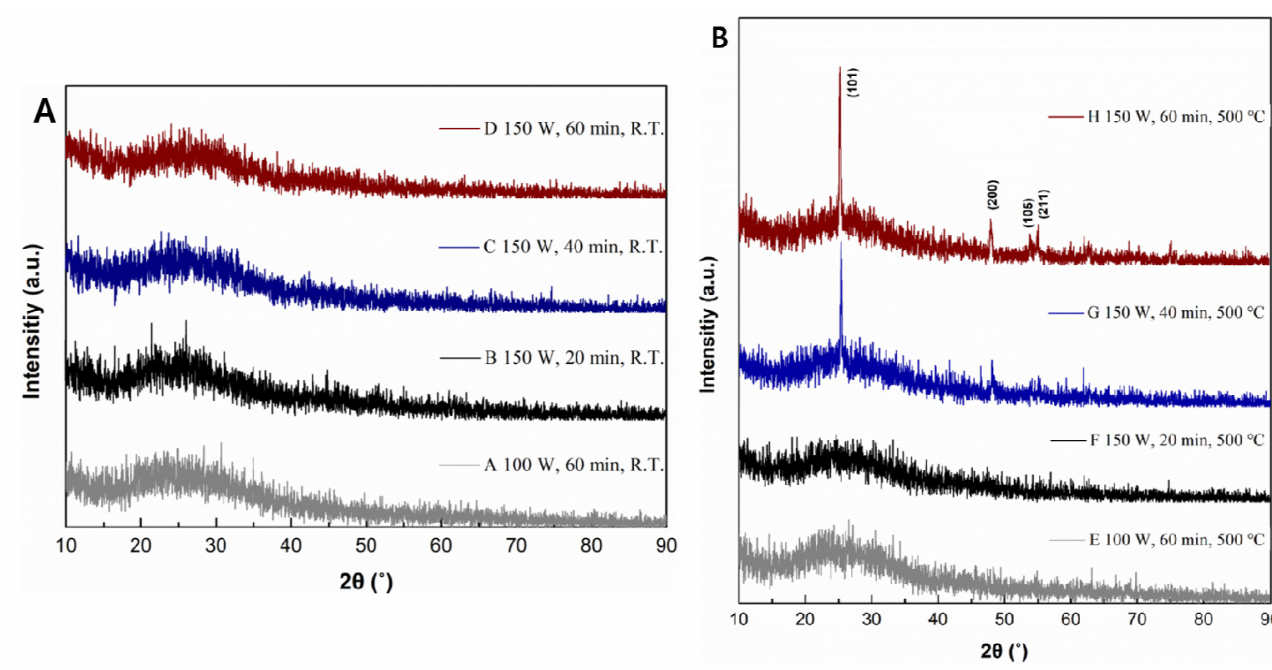
Figure 8. XRD pattern of ( A ) the TiO x thin films (non-annealed) and ( B ) TiO 2 thin films (annealed at 500 ◦